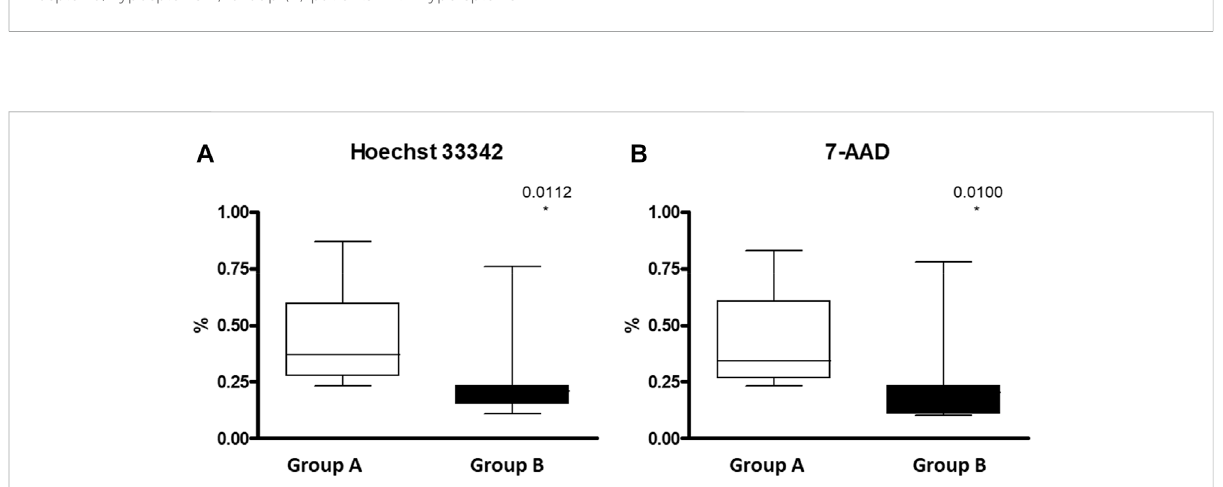
FIGURE 6 HJB inside RBC measured by FC in asplenic/hyposplenis vs. hypersplenic SCD subjects: (A) Hoechst 33342 for A and T nucleotides and (B) 7- AAD (7-amino-actinomycin D) for C and G nucleotides. Group (A) patients with asplenia/hyposplenism, ( n = 13). Group (B) patients with hypersplenism, ( n =